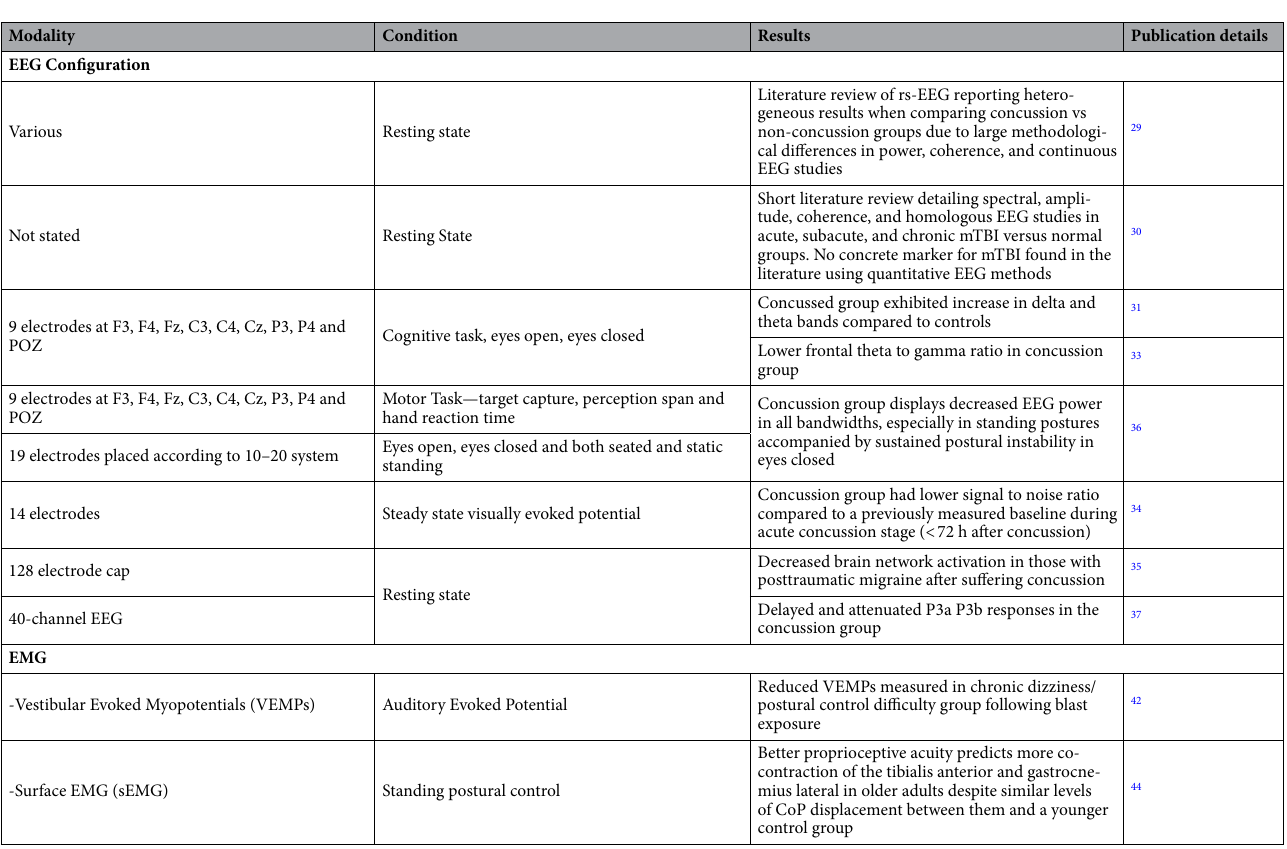
Table 1. summarizes the author´s literature review in quantitative assessment of concussion using neurophysiological